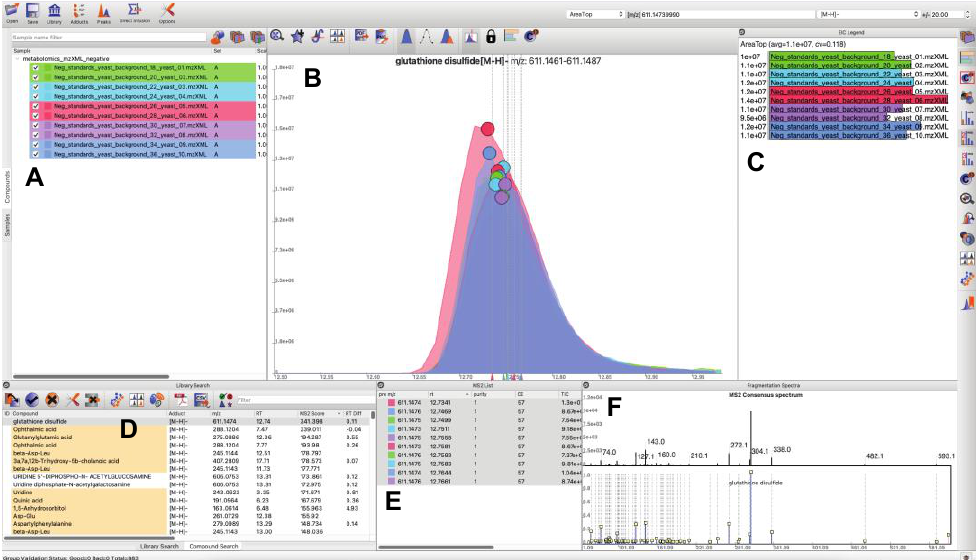
Figure 2. MAVEN2 User Interface. The MAVEN2 user interface presents all relevant information for compound validation in a single view. This view includes a list of loaded samples ( A ), overlayed EICs from multiple samples ( B ), sample-specific quantitation information ( C ), the result of a fragmentation spectral library search ( D ), a list of MS/MS events associated with a putative identification ( E ), and spectral matches between a consensus MS/MS spectrum and the library spectrum ( F ). Shown above is a match to a library spectrum of glutathione disulfide.